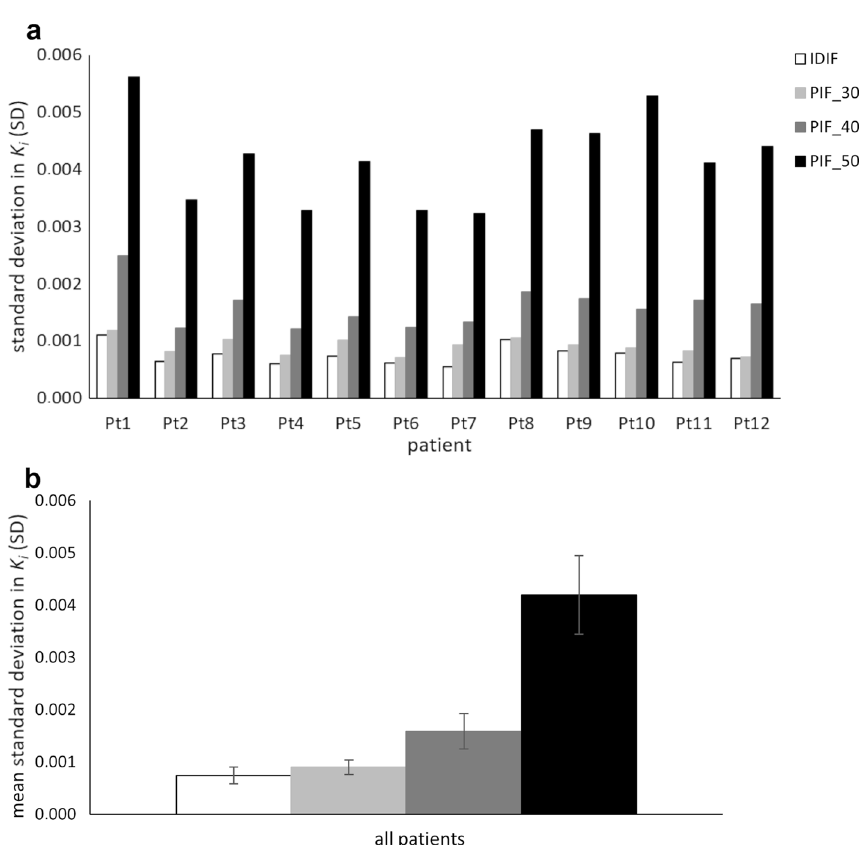
Fig. 5 Bar plots of K i SD obtained from the liver VOI (as indication for Patlak image noise) per patient ( a ) and for all patients ( b ) generated with IDIF and various PIF at shorter scan time intervals